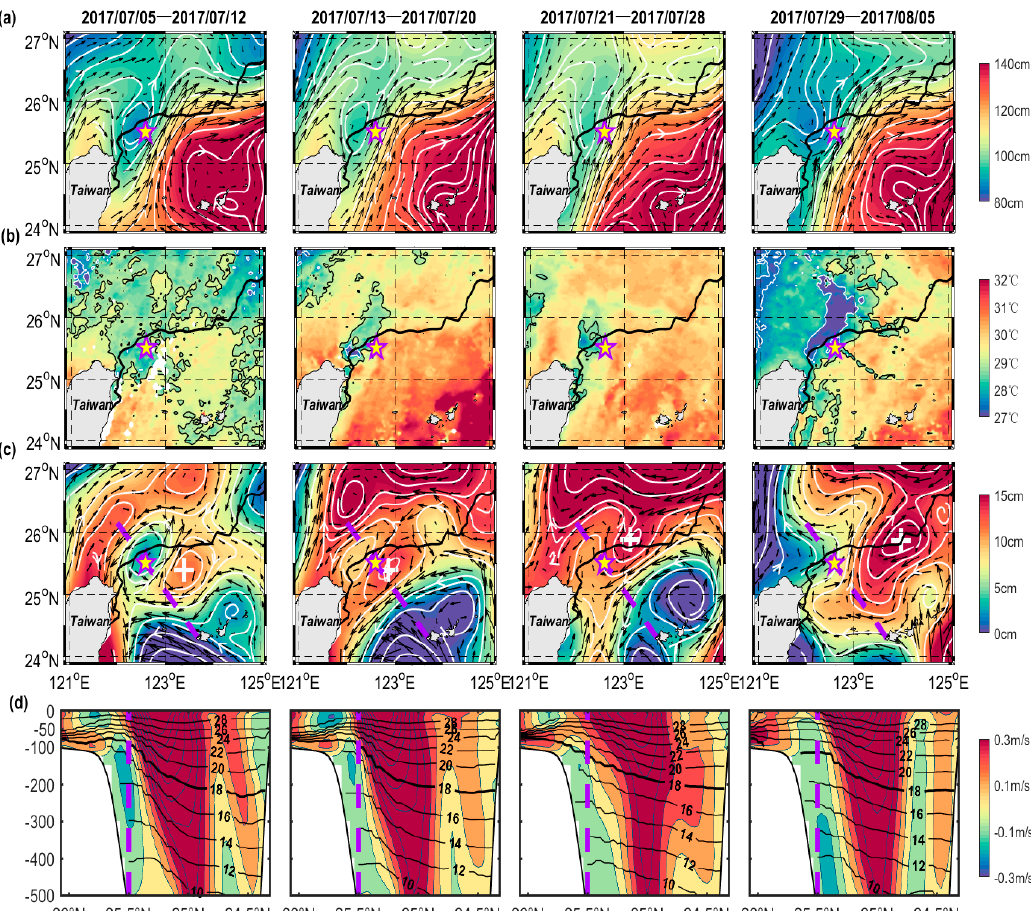
to the northeast of Taiwan is marked by a white ‘+’ symbol. ( d ) Vertical distribution of normal velocity (colors) along section NL (Figure 1) derived from the analysis data; the black solid lines denote isotherms, the black bold solid line denotes the 18 °C isotherm, and the purple dashed line denotes the ADCP mooring site.